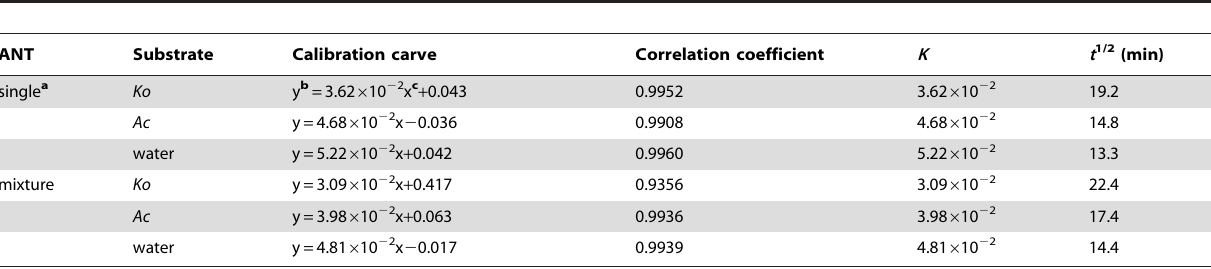
Table 1. Kinetic results for the photodegradation of ANT adsorbed onto the leaves of two typical mangrove species (n= 9) and dissolved in water (n=9) as single compounds and in multicomponent mixtures.